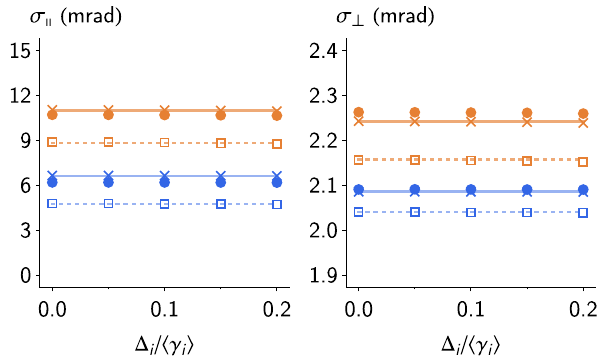
FIG. 2. Parallel and perpendicular standard deviations as a function of initial energy spread m Δ , for an electron beam with i i ¼ 500 (orange) and 1000 MeV (blue) mean initial energy m h γ i colliding with a laser pulse with a 0 ¼ 20 : simulation results with quantum (filled circles), classical (crosses), and no (squares) radiation reaction (as in Fig. 1) and theoretical predictions Eqs. (1) and (2) with (solid curves) and without (dashed curves) RR, assuming that the beam is monoenergetic at the mean